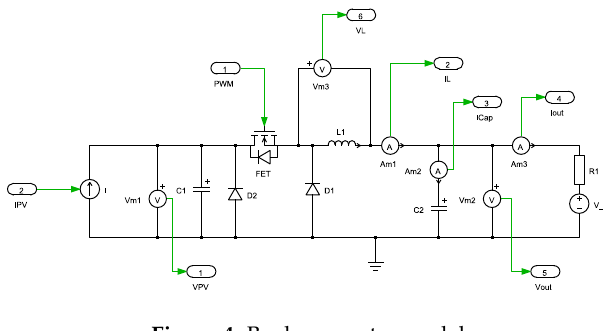
Figure 4. Buck converter model.